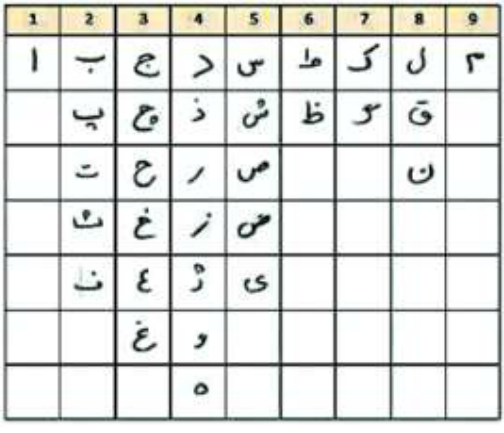
Figure 2. Persian character categories